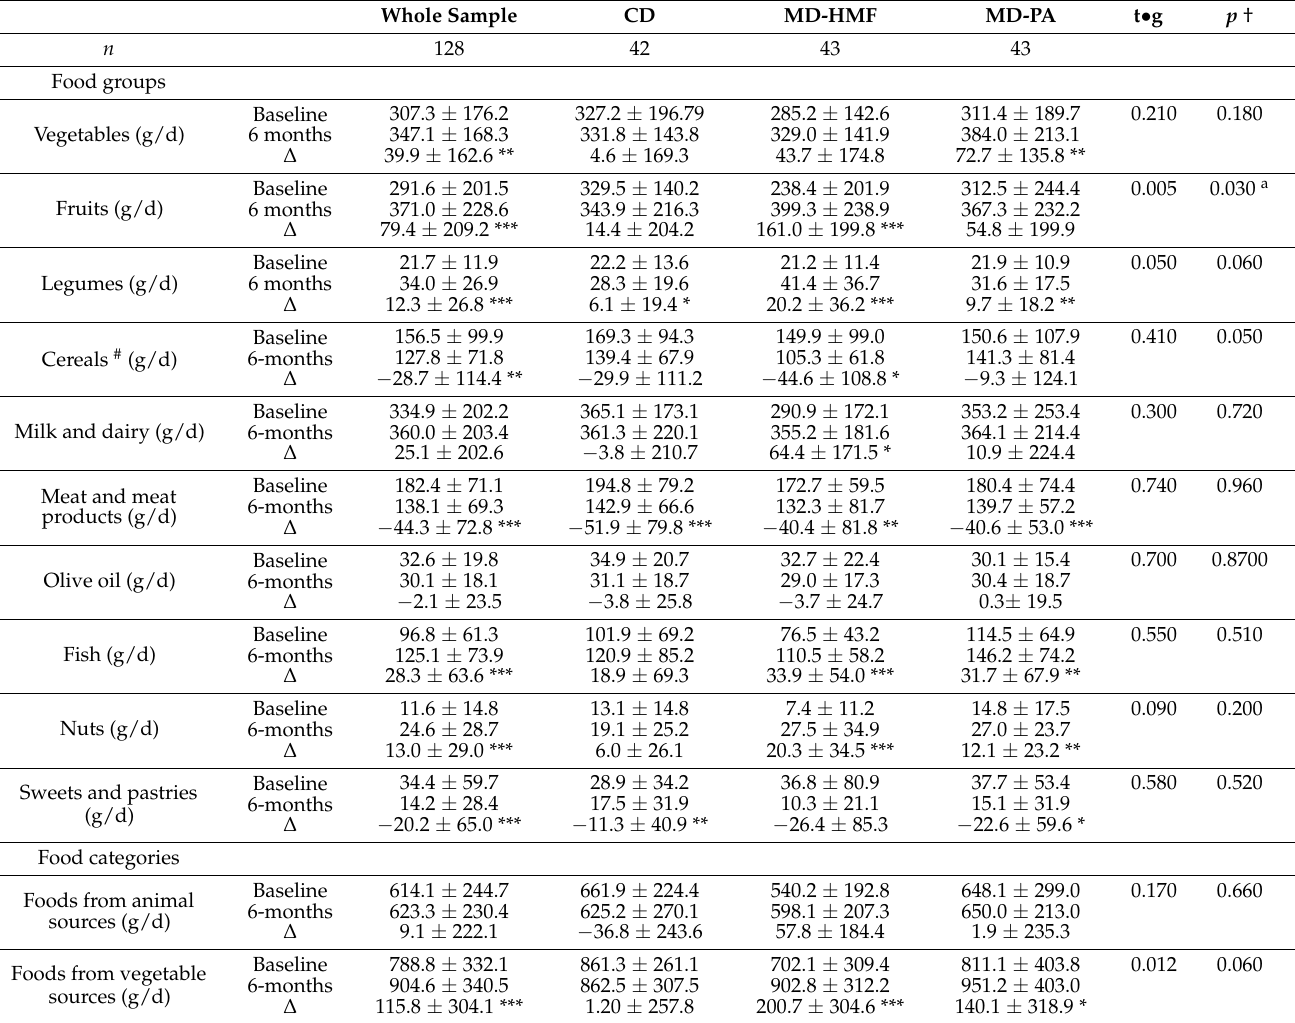
products, and sugary foods, such as sweets and pastries, as shown in Table 6. Differences between groups were observed in fruit consumption only, where the MD-HMF group significantly increased fruit consumption compared to the CD group ( p = 0.030). Time per group interaction was significant for consumption of fruit ( p = 0.005) and foods from vegetables sources ( p = 0.010). Table 6. Changes in food groups and food categories intakes within and between intervention groups at 6 months ver- sus